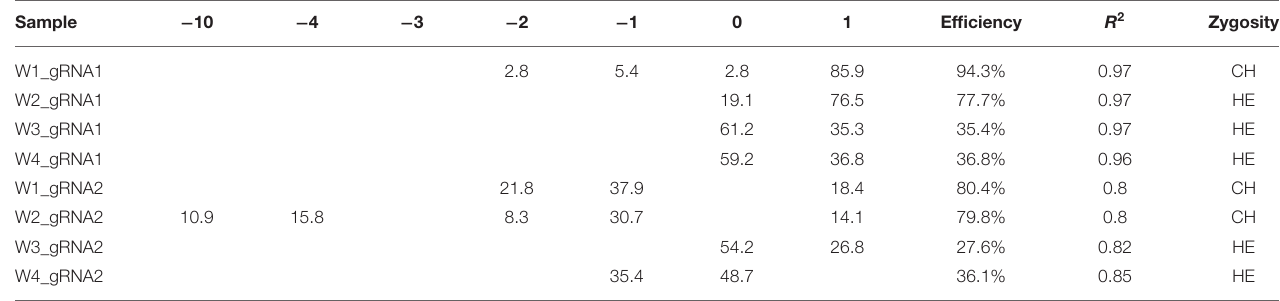
TABLE 2 | Genotyping of targeted gene mutations induced by CRISPR/Cas9 in T 0 generations in the four edited lines. Sample − 10